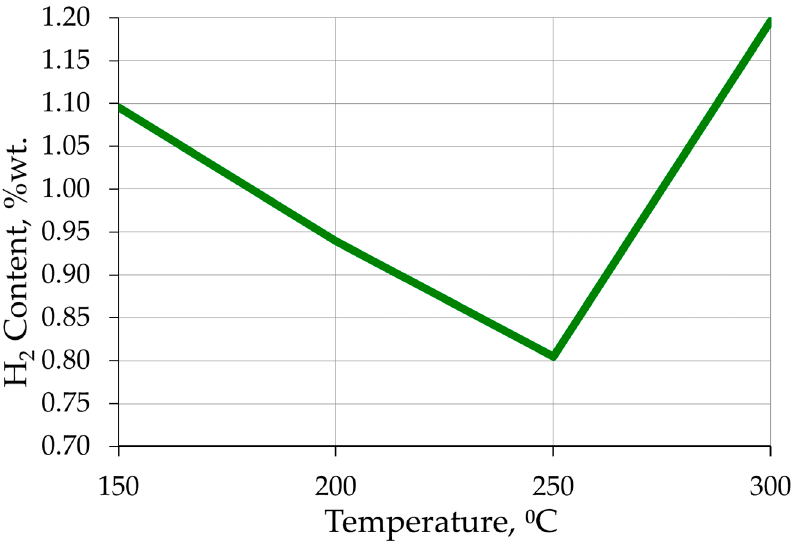
Figure 2. The content of evolved hydrogen gas depending on the temperature of the process.